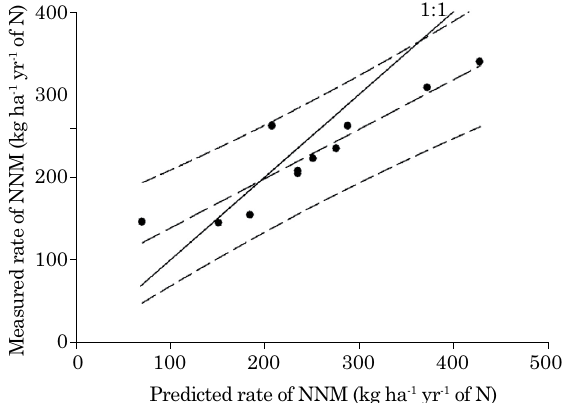
figure 4. measured versus predicted rates of net nitrogen mineralization (NNm) [ŷ = 72.7 + 1.41 x, R 2 = 0.84, model efficiency (EF) = 0.35, n = 11] showing the 95 % confidence interval of prediction in relation to the 1:1 line.